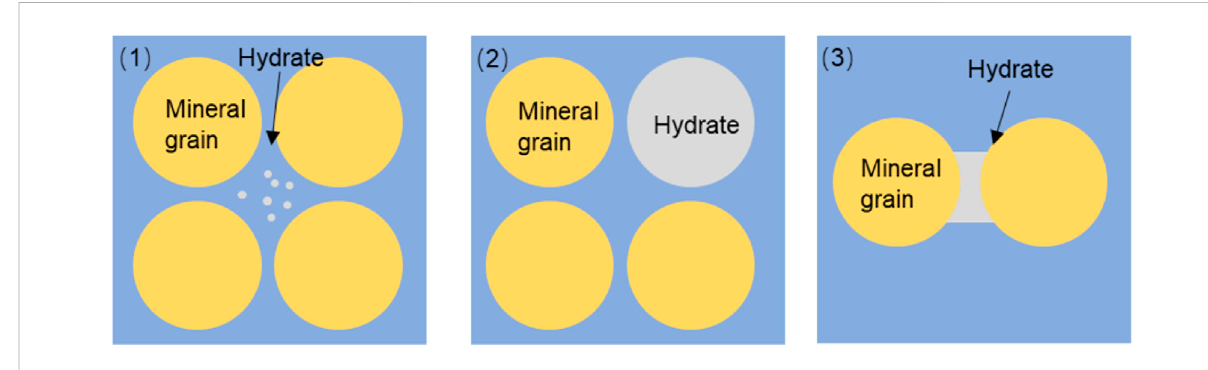
Scheme showing the three hydrate morphologies.